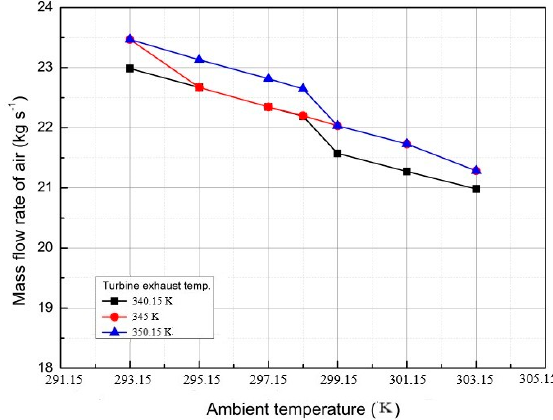
ff erent ambient